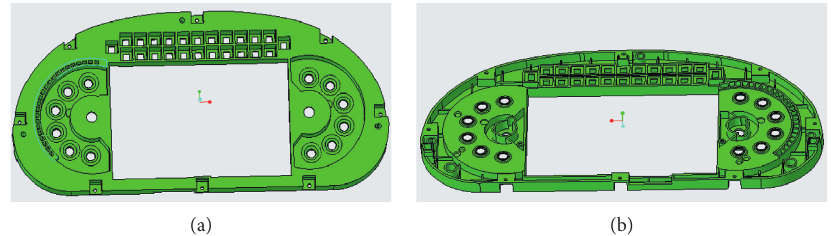
Figure 1: 3D model of automobile instrument light guide bracket: (a) front view and (b) the reverse